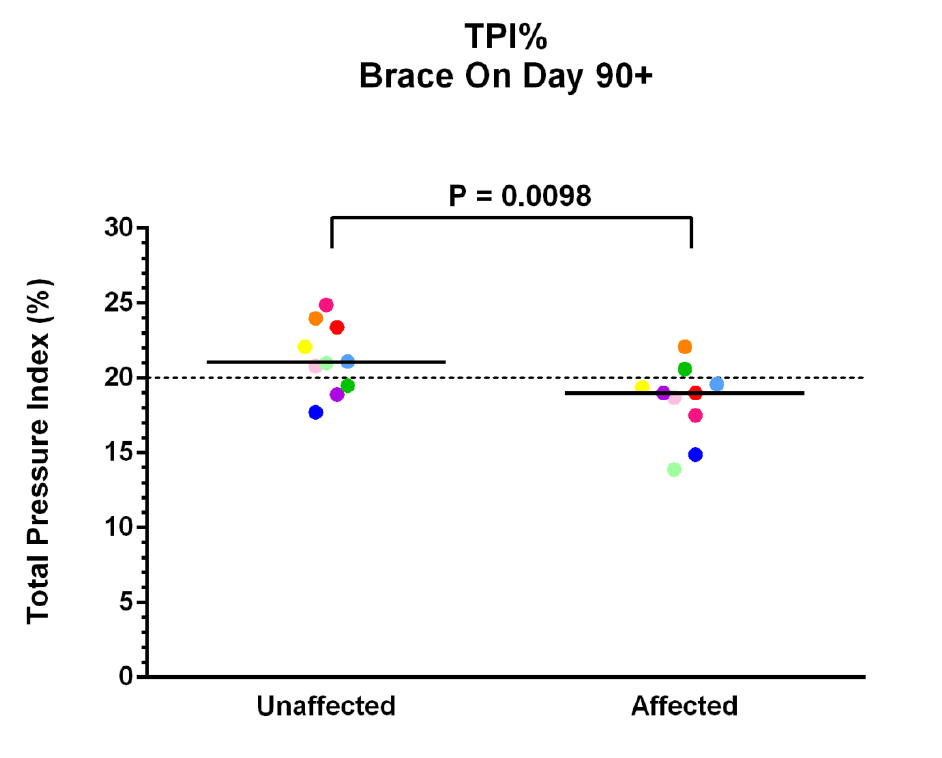
Figure 3: Patient TPI% at day 90+ With the Orthotic